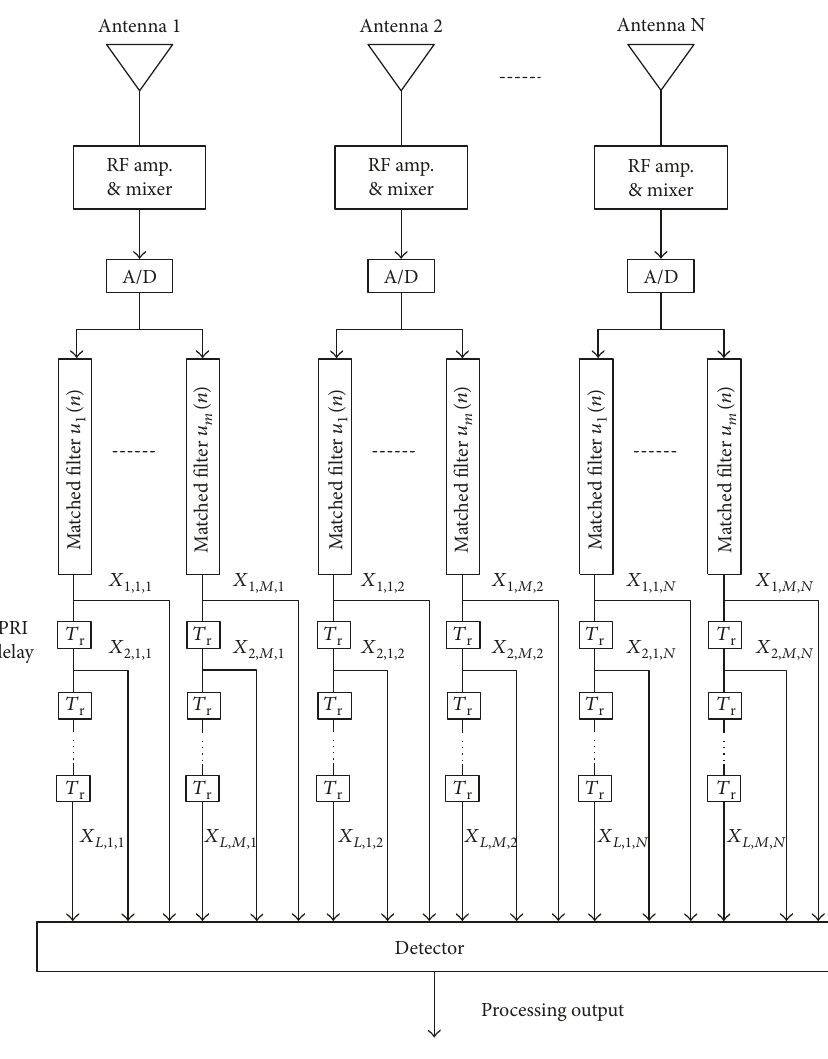
Figure 1: Structure of MIMO radar receiver in a